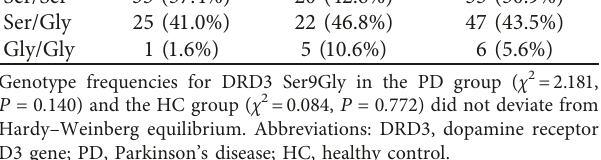
Hardy–Weinberg equilibrium. Abbreviations: DRD3, dopamine receptor D3 gene; PD, Parkinson’s disease; HC, healthy